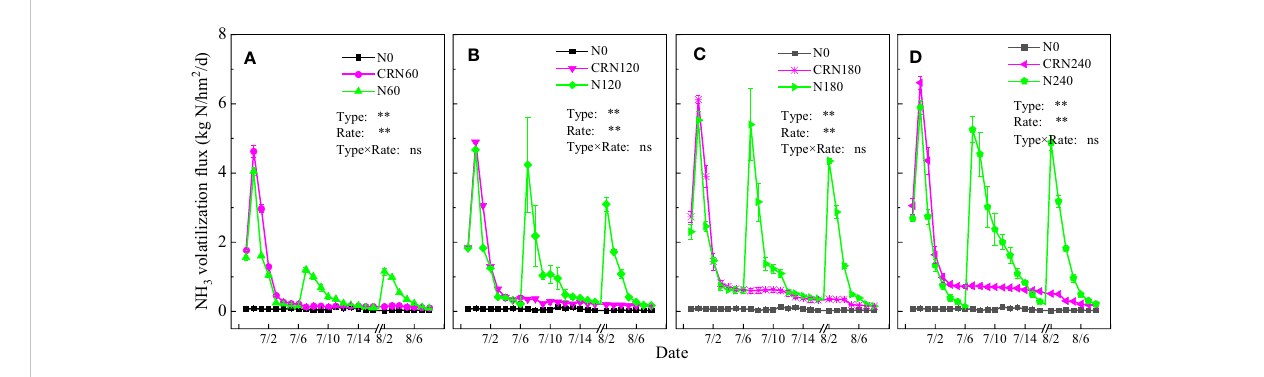
FIGURE 6 NH 3 volatilization fl ux under the blended CRN treatments (red graph) and conventional N fertilizer treatments (green graph) with applied N rates of 0, 60, 120, 180, and 240 kg/hm 2 in the 2019 rice season (A – D)